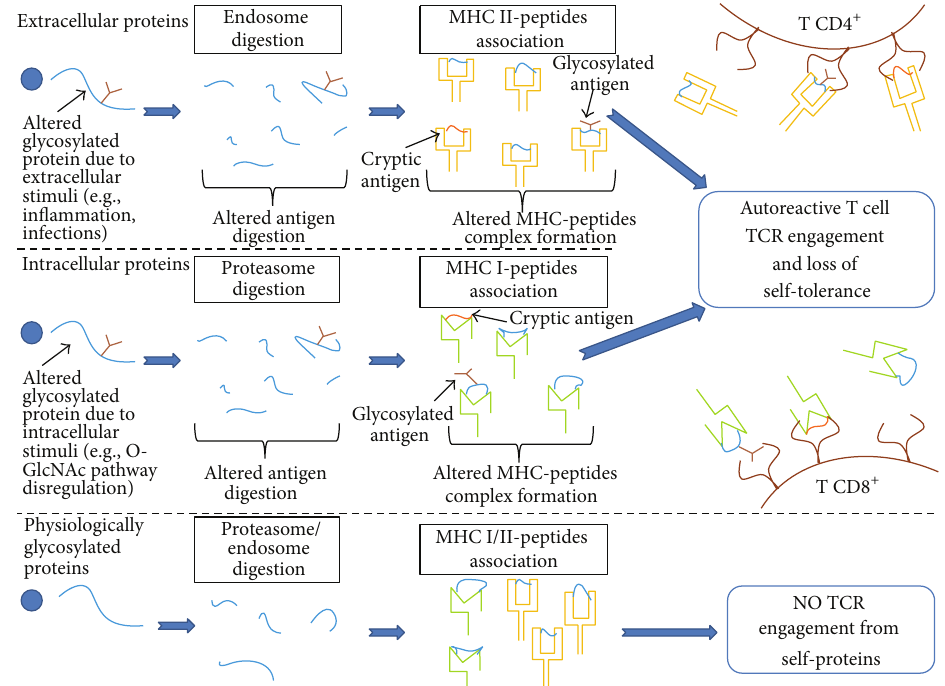
Figure 1: Aberrant glycosylation affects antigen presentation and can induce breaking of tolerance. (Of note, due to the cross-presentation pathway, intracellular proteins with altered glycosylation could be presented on MHC II molecules to T CD4 +